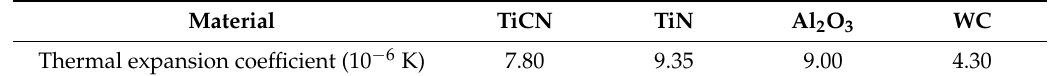
Figure 9. The fractured cross-sectional SEM images and the EDS results of the fragmented coated WC-Co hardmetal scrap at different oxidation times. ( a ) 10 min; ( b ) 30 min; ( c – e ) 300 min. Table 2. Thermal expansion coefficients of